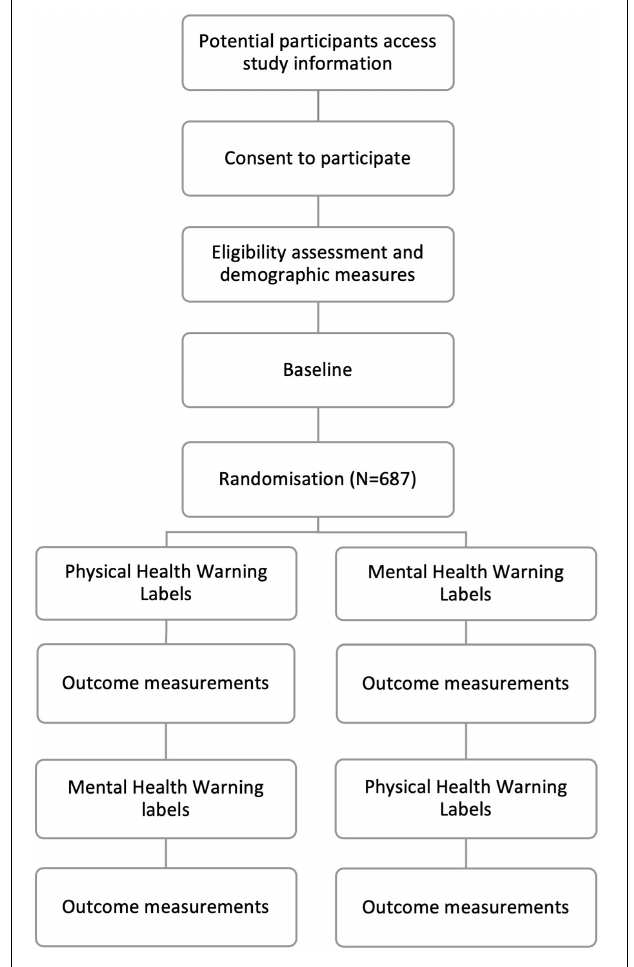
FIGURE 1 | Study flow